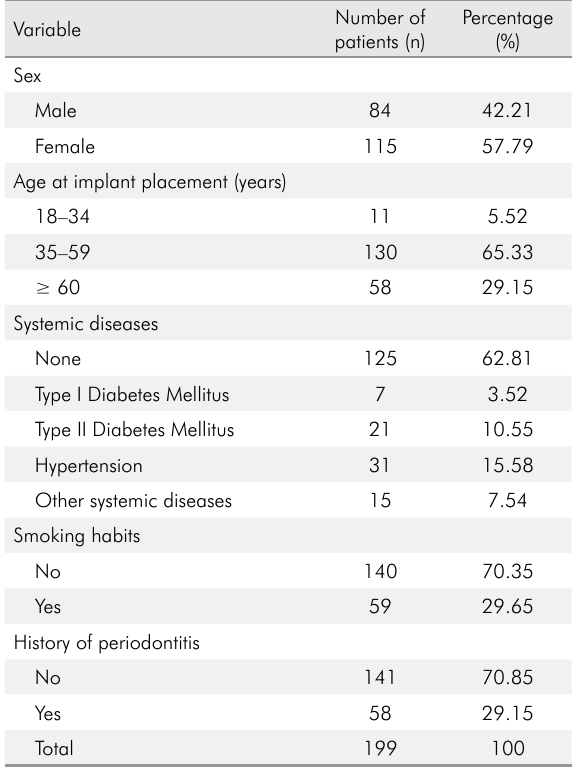
Table 1. Frequency distribution of different variables in relation to